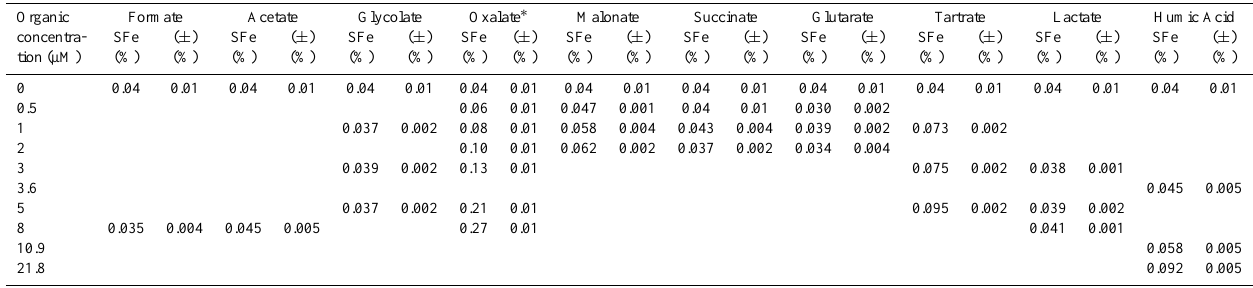
Table 2b. Iron solubility obtained for the dissolution experiments from Niger dust at pH 4.7 and for various atmospheric concentrations of organic